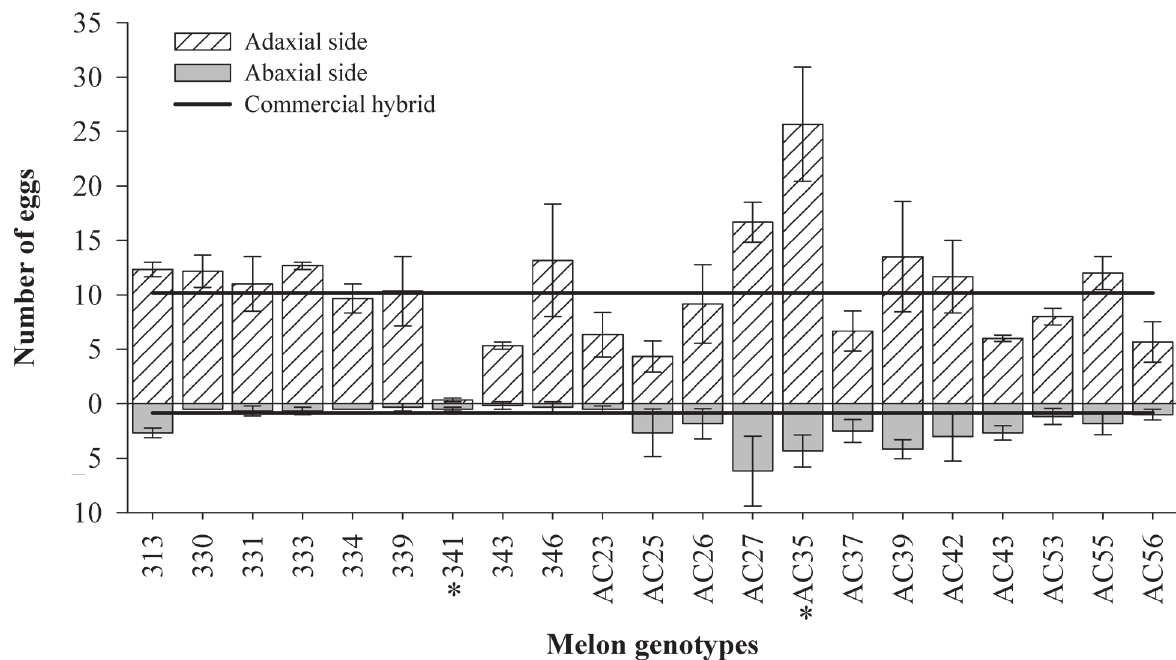
Figure 1. No preference of L. sativae for oviposition in melon genotypes. Genotypes followed by an asterisk indicates a signifi cant difference in relation to the commercial hybrid by Dunnett’s test (α = 0.05). Line in bold (mean number of eggs in the leaves of the susceptible standard genotype), Bars (mean number of eggs in leaves of genotypes with standard